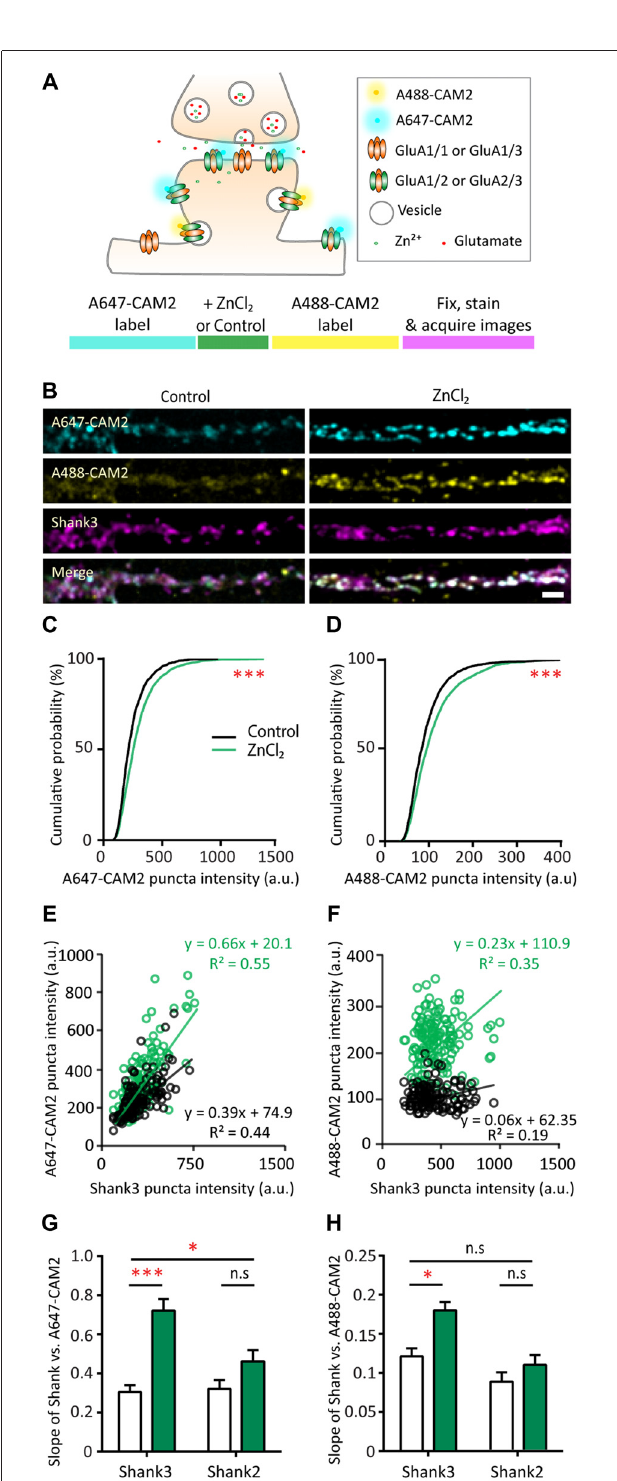
FIGURE 9 | Probing mechanisms of zinc-dependent AMPAR trafficking with CAM2. (A) Schematic of sequential dual chemical labeling of GluA2 subunit of AMPAR using A647-CAM2 and A488-CAM2 reagents (top). Sequence of the labeling experiment using CAM2 to probe zinc-dependent AMPAR trafficking (bottom). (B) Straightened dendrites of hippocampal neurons were pre-labeled